Question: Write a descriptive caption for this figure.
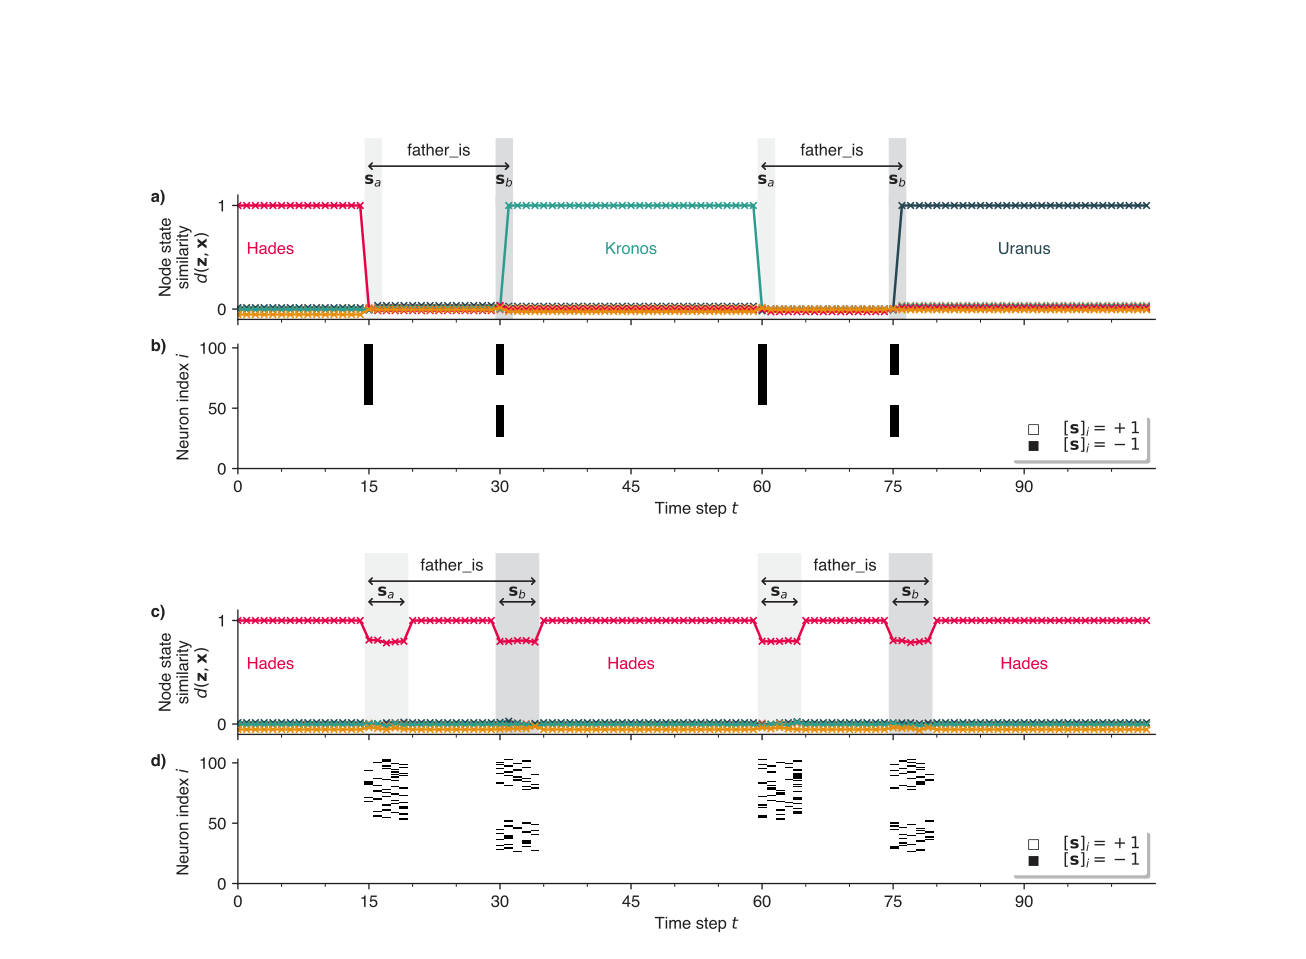
Answer: An attractor network constructed via the simpler weights construction method specified in Section VII-C, with input to the network modelled as Hadamard product binding, rather than component-wise masking. a) The similarity of the network state zt to stored node hypervectors, when the stimulus hypervector s is applied on one time step for all neurons simultaneously. b) A subset of the stimulus hypervector s at each time step in this synchronous case. c) The attractor overlaps in the asynchronous case, where the stimulus s is applied over multiple time steps randomly. d) A subset of the stimulus hypervector s at each time step in this asynchronous case. For visual clarity, the two stimulus hypervectors shown were manually chosen rather than randomly generated. In the synchronous case, the network performs the correct walk between attractor states as intended. In the asynchronous case however, the stimuli fail to effect the desired transitions, since any changes in the network sta